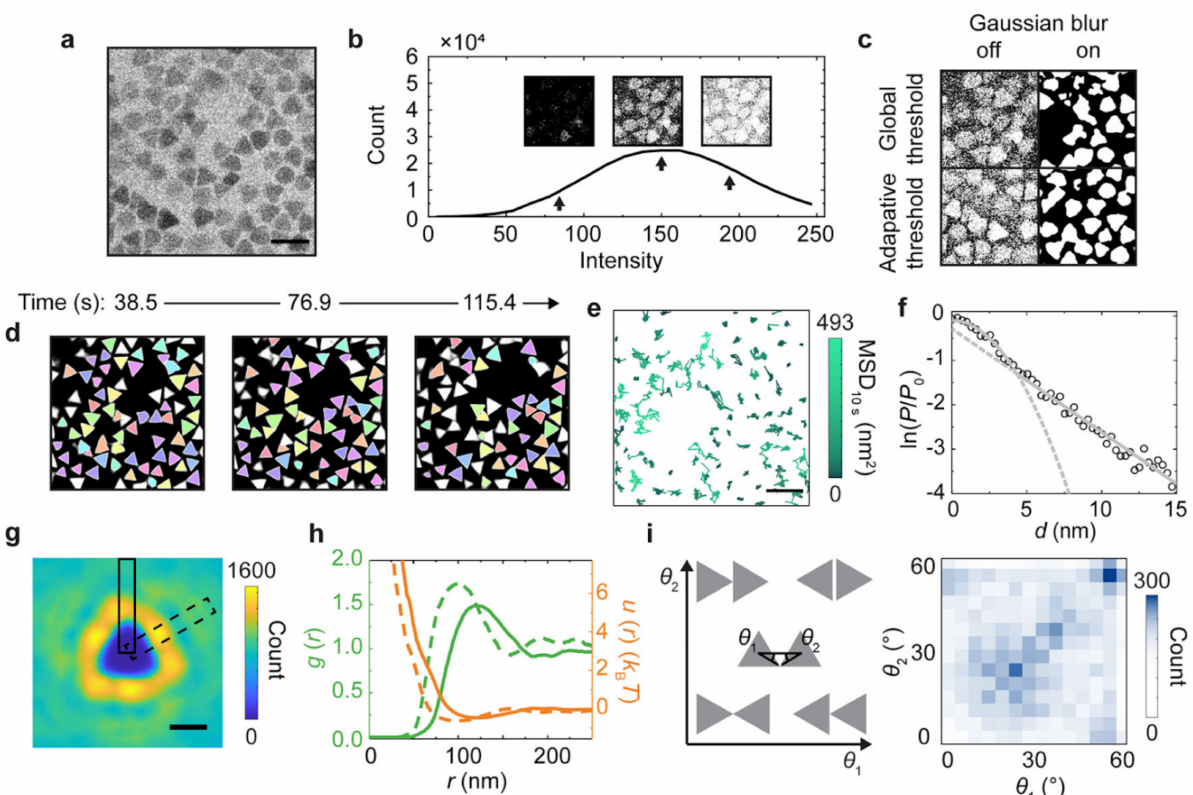
Figure 11. Statistical analysis of the diffusion, structure, and interaction landscape of gold triangular nanoprisms imaged by liquid-phase TEM, enabled by accurate segmentation based on the trained U-Net [109] model. ( a ) Raw liquid-phase